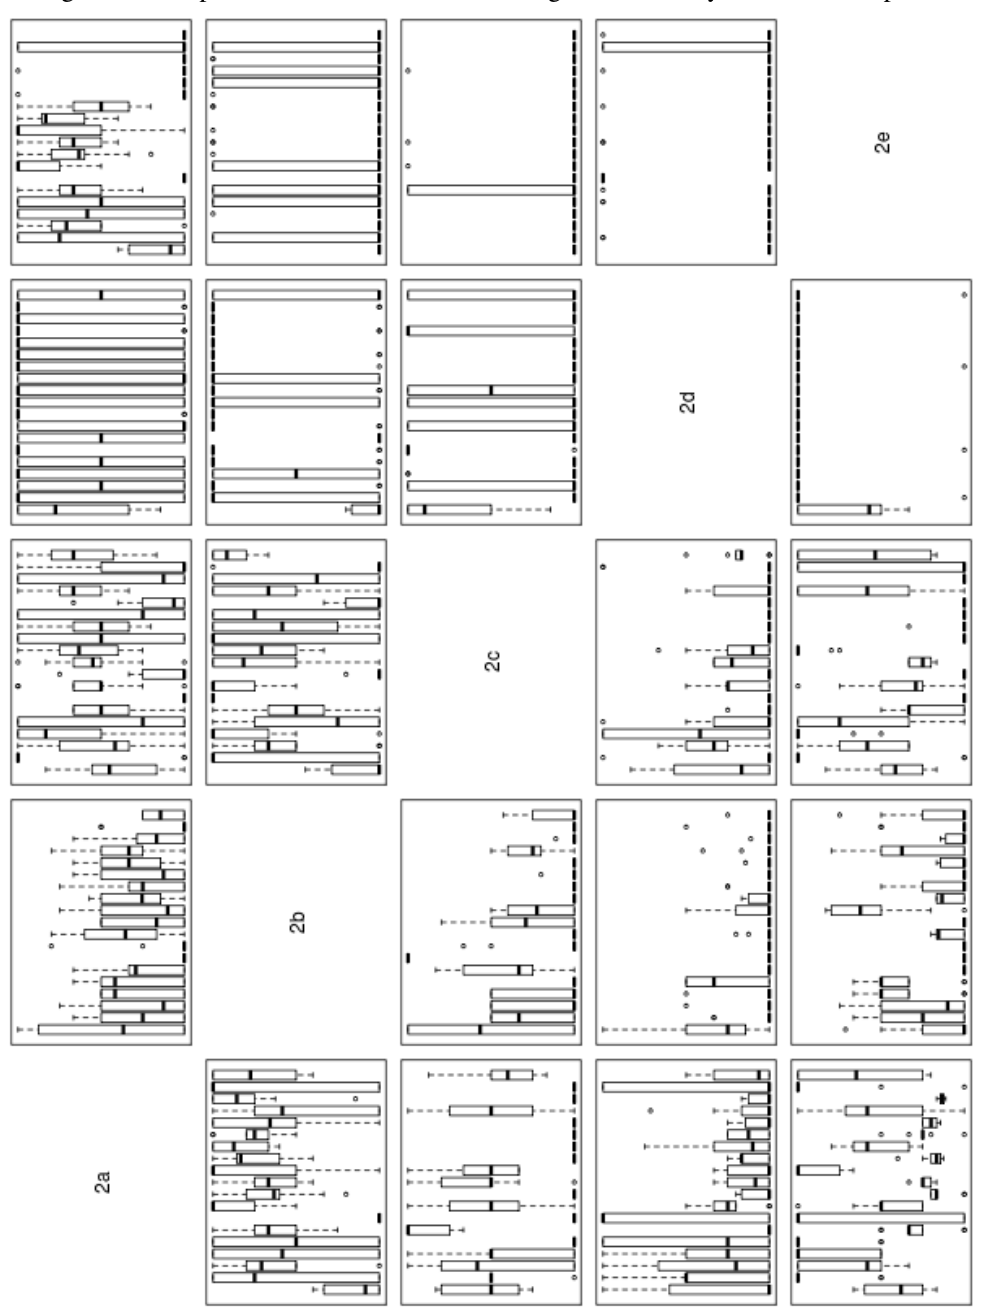
Figure 6: Comparison of the Pareto fronts using C-measure by means of box-plots.